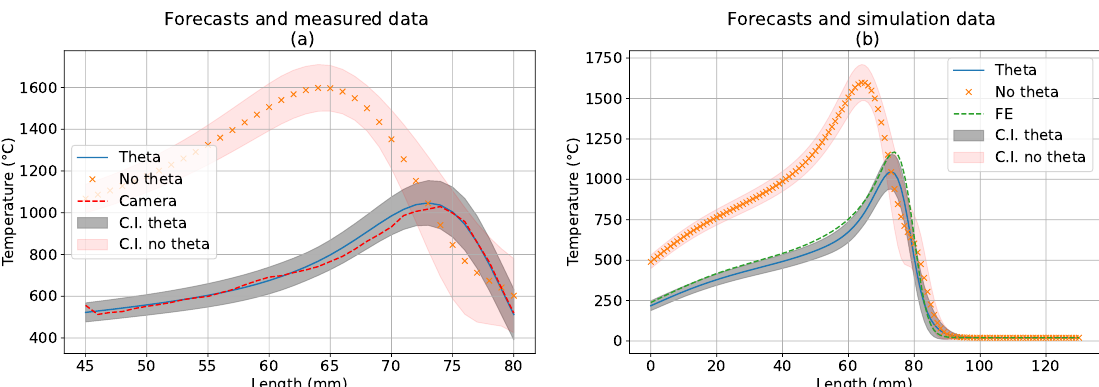
Figure A1. Forecasted temperature conditioning by the known parameters ( µ ) and by the known and unknown parameters ( µ , θ ) with their correspondent confidence interval. ( a ) Compared to experimental camera data. ( b ) Compared to FE results.